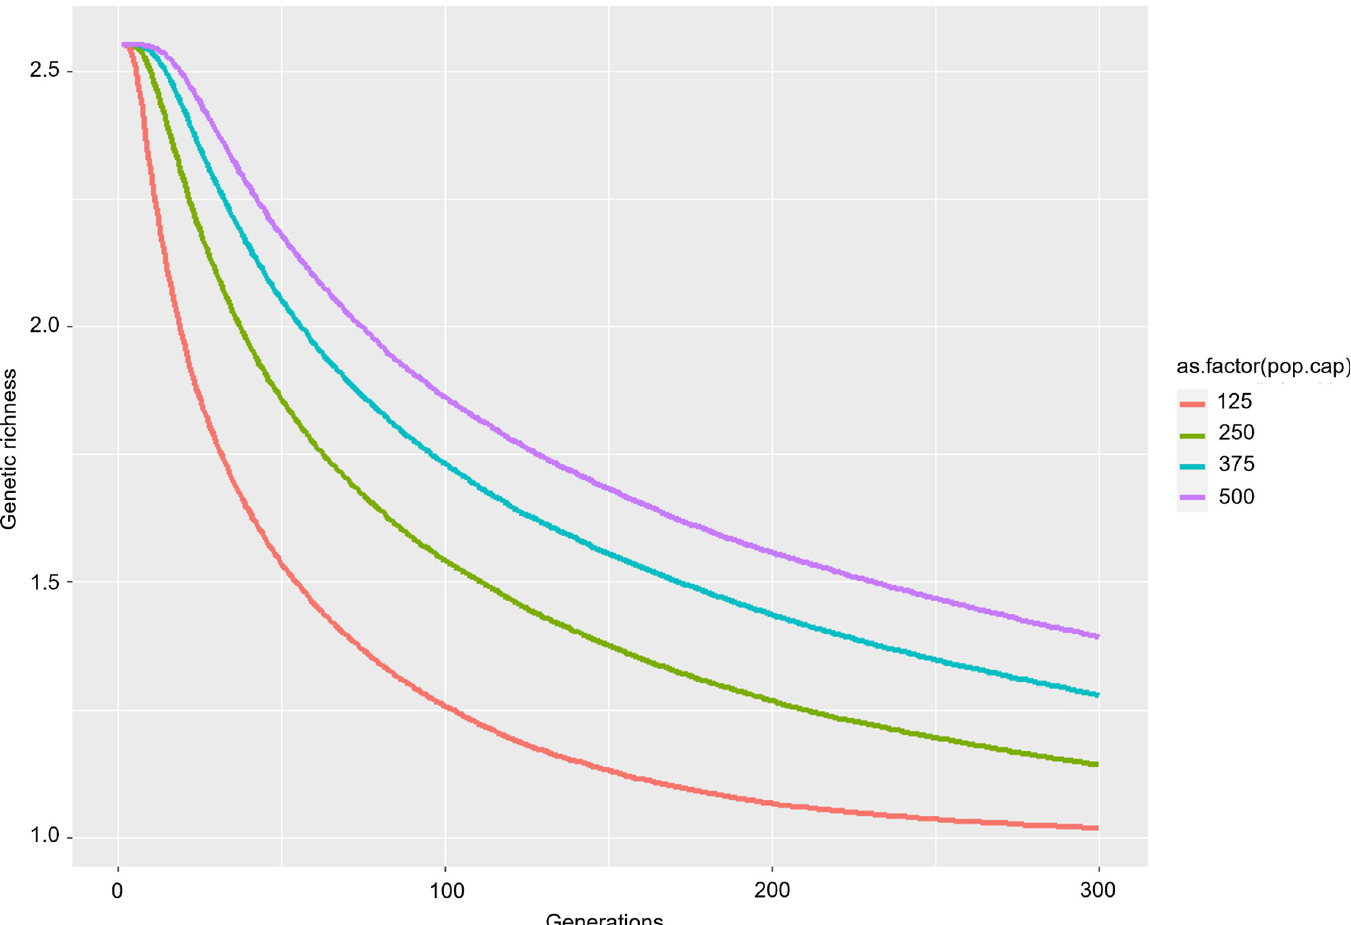
Fig 4. Simulation results showing the relationship between generations and genetic